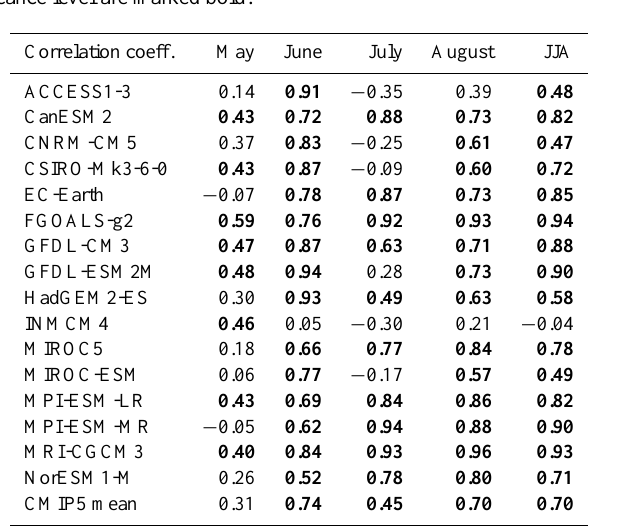
Table 3. Correlation between ice albedo and snow depth, averaged over 80–90 ◦ N. Correlations that are significant at the 95% signifi- cance level are marked bold.